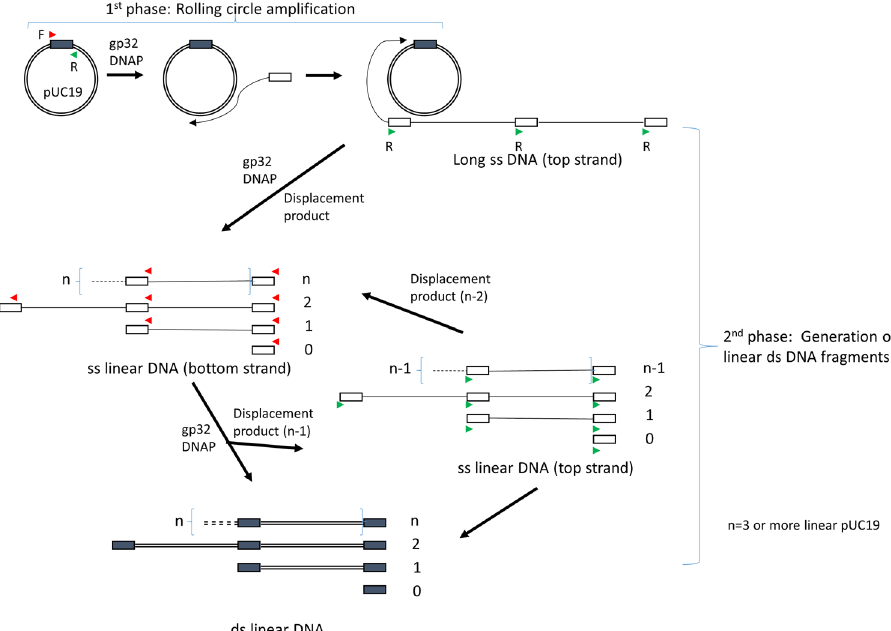
Figure 6. A model of gp32-assisted isothermal amplification on circular templates. The amplicon (depicted as a box) is specified by a pair of primers (forward, F, red arrow and reverse, R, green arrow) on the circular ds pUC19 template (circle). The amplification is proposed to occur in two phases. In the first phase, with the help of gp32 protein both primers (for simplicity only the product from F primer is shown) invades dsDNA and initiates DNA synthesis by a strand-displacing DNA polymerase to produce long single-stranded DNA corresponding to the top strand sequence of pUC19. For circular ssDNA template, this phase occurs similarly but does not require a strand invasion step. In the second phase, which is also facilitated by gp32, this single stranded product serves as the template for the reverse primer (R, green arrow) for DNA synthesis in the opposite direction. As there is one primer site at each amplicon for every length of the pUC19, discrete sizes of ssDNA products (bottom strand) are generated through strand displacement synthesis at multiple sites and they consist of a single amplicon and larger species of one or more entire length of the linear templates (n) linked with a single amplicon at one end. After another round of priming and DNA synthesis by the other primer (red arrows), these ssDNA species are then converted to dsDNA fragments which migrate as discrete bands in agarose gels. At the same time, ssDNA species of the opposite strand (top strand) are also generated in a similar displacement synthesis but one linear pUC19 shorter (n-1) and they are converted to ds fragments in subsequent round of